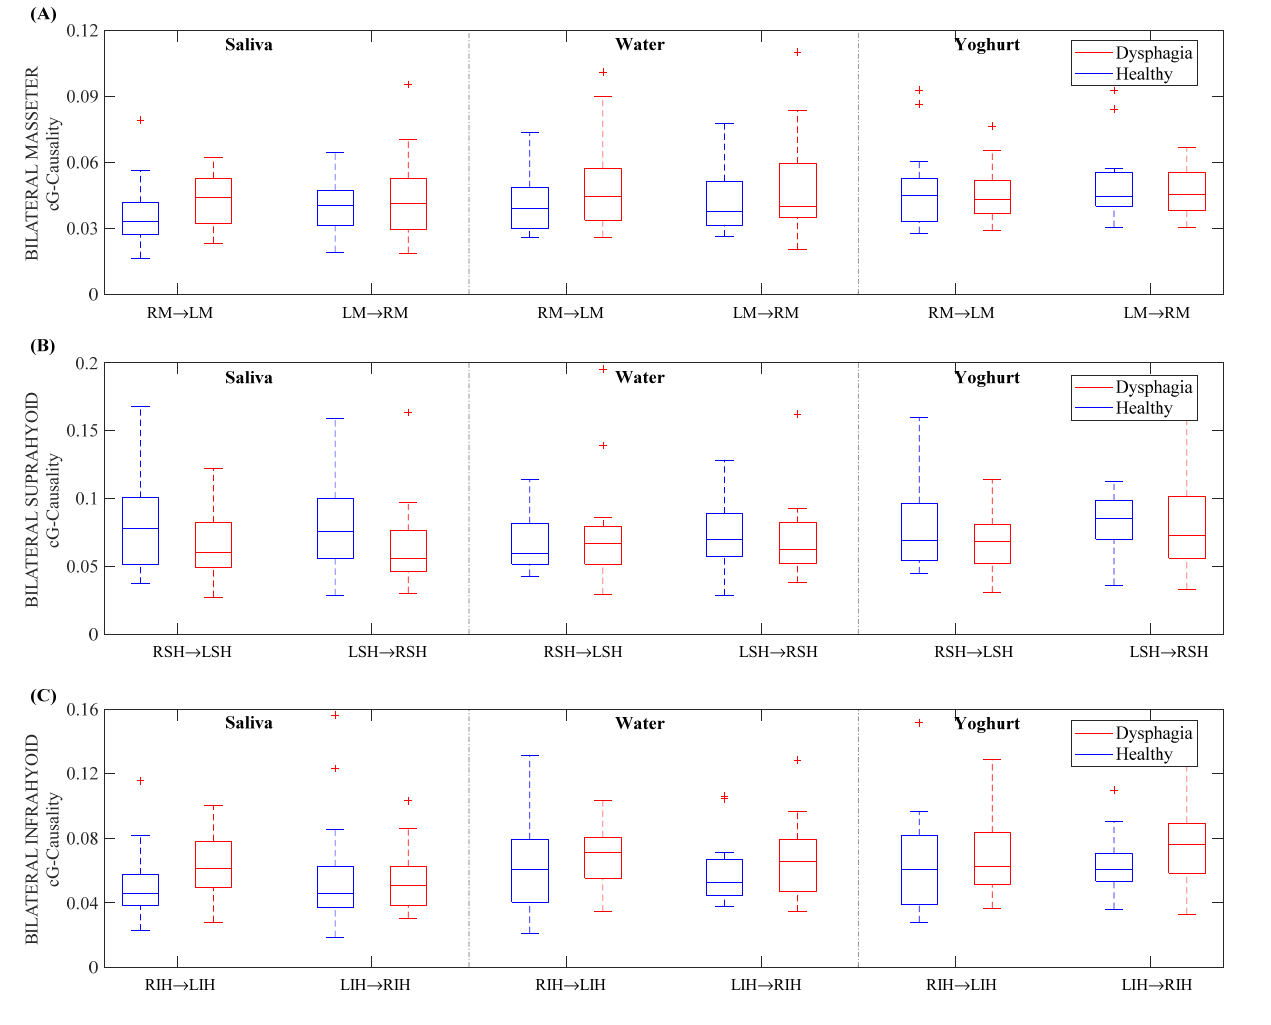
Figure 3. Box-and-whisker plot of the cG-causality values for bilateral muscles in healthy and dys- phagic subjects for saliva, water, and yoghurt boluses. ( A ) Masseter, ( B ) suprahyoid, ( C ) infrahyoid.